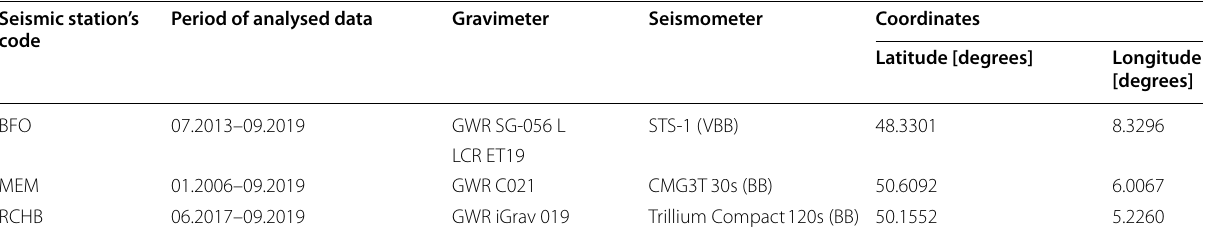
All data were downloaded from the IRIS database